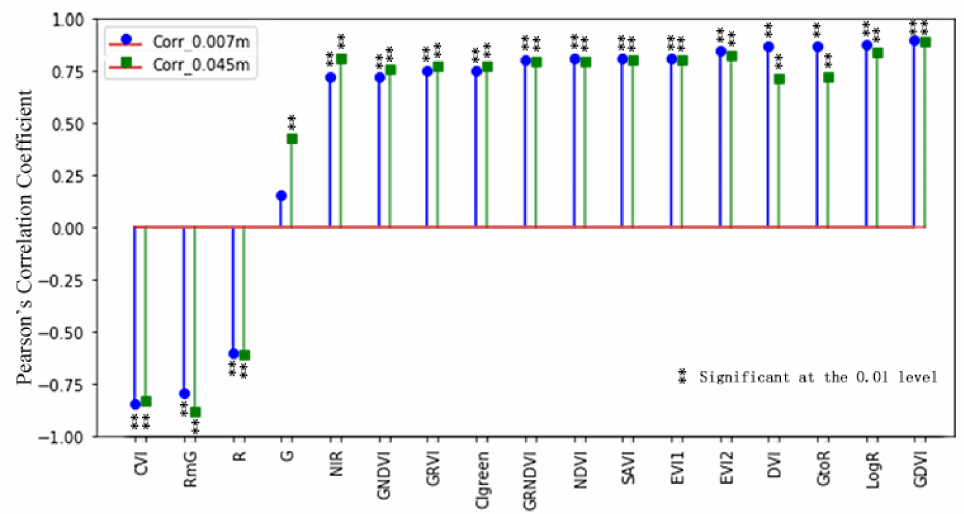
Figure 7. Pearson’s correlation coefficients between LAI_viti and vegetation indices (VIs) derived from UAV multispectral images from 0.007 m (n = 148) and 0.045 m (n = 145) GSD data.